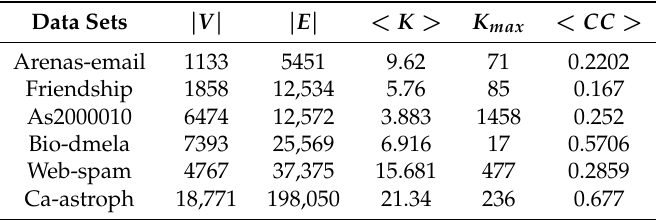
Table 3. The statistics of six real-world complex networks: Node number | V | , edge number | E | , average degree < K > , maximum degree K max , and clustering coefficient < CC >